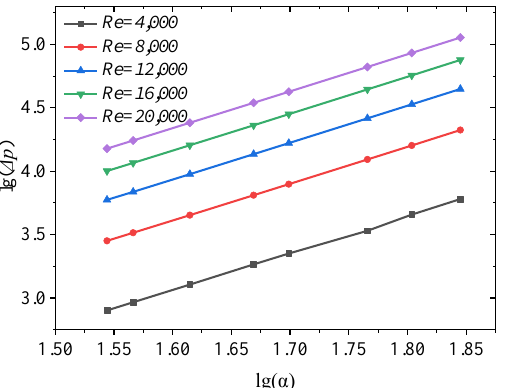
Figure 13. Logarithmic relationship between aspect ratio and pressure drop.